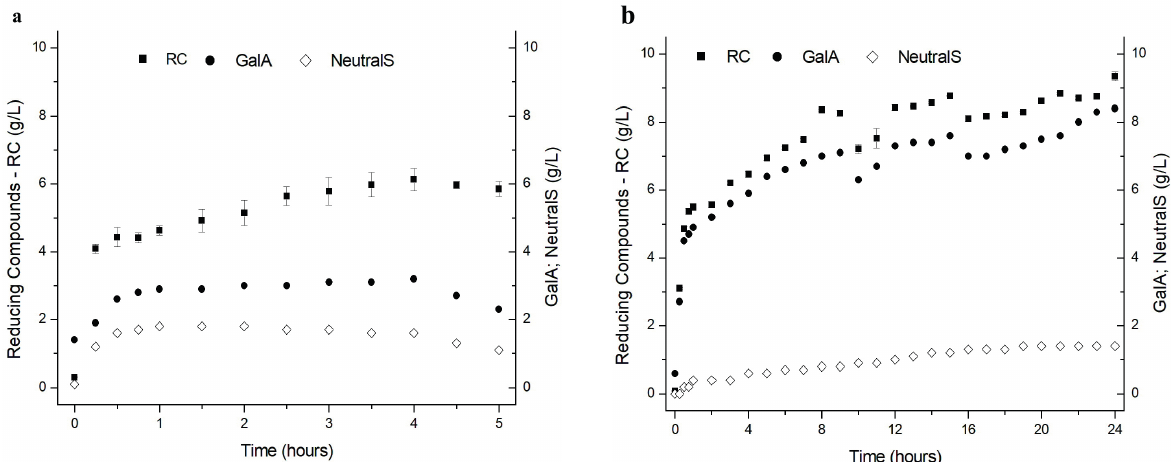
Figure 3 – Release kinetics of reducing compounds during acid hydrolysis of pectin ( a ) – with 1.0% v/v H2SO4; 100 oC; 1.0% (w/v) pectin; and during enzymatic hydrolysis of pectin ( b ) - with 10.01 UI/g of enzyme; 230.3 rpm; 1.0% (w/v) of